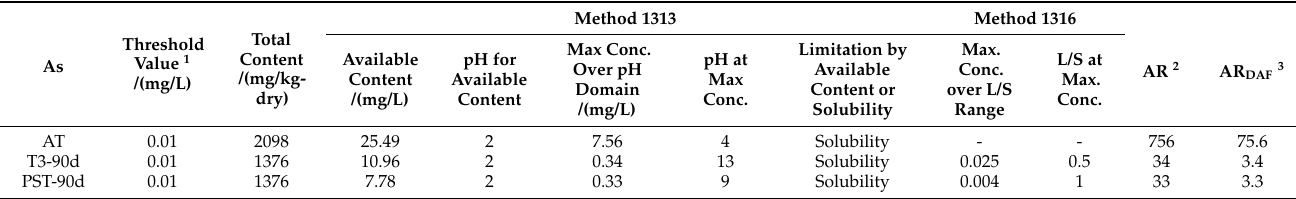
Table 4. Full As LSP screening assessment, leaching assessment ratios (ARs), and leaching ARs considering dilution and attenuation (ARDAF) for AT, T3-90d, and PST-90d.